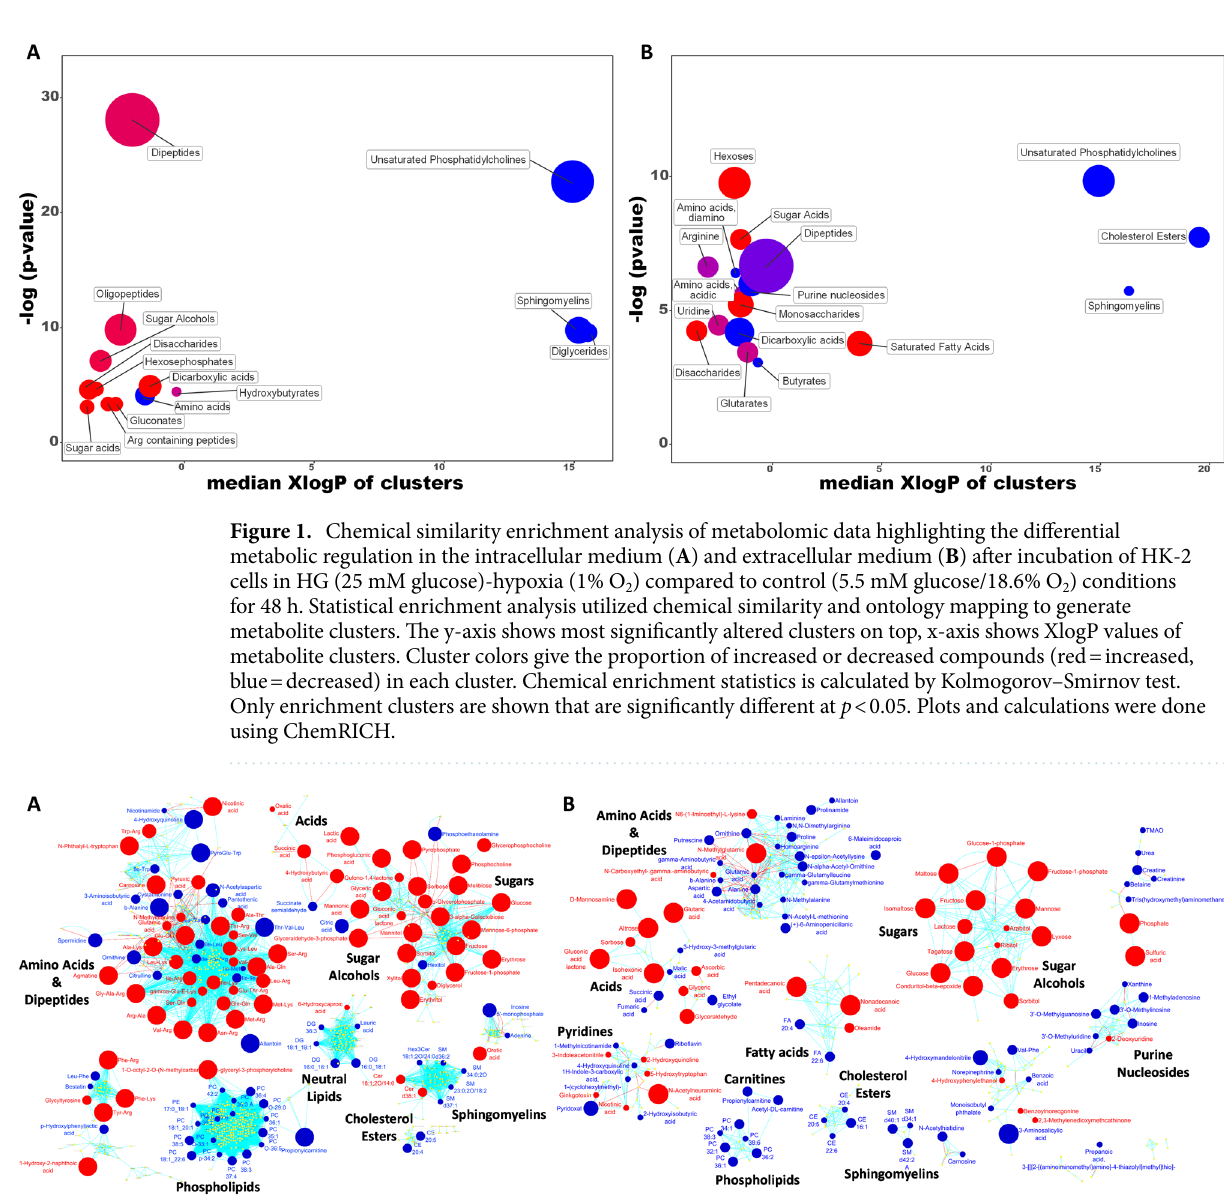
Figure 2. MetaMapp visualization of metabolomic data highlighting the differential metabolic regulation in cell extracts ( A ) and extracellular medium ( B ) after incubation of HK-2 cells in HG (25 mM glucose)-hypoxia (1% O 2 ) compared to control (5.5 mM glucose/18.6% O 2 ) conditions for 48 h. Red edges denote KEGG reactant pair links and light blue edges symbolize Tanimoto chemical similarity at T > 700. Metabolites found significantly increased (FC > 2) are given as red nodes and blue nodes give decreased metabolites (FC < 0.5). Node sizes reflect fold change. Metabolites that were not found to be differentially regulated are given as yellow nodes and left unlabeled for visual clarity. Significance determined using Mann–Whitney U test with FDR < sugar acids were significantly increased. In the extracellular medium, unsaturated PC and SM were decreased as in the cellular extracts, and CE, amino acids (diamino), purine nucleosides, dicarboxylic acids and butyrates were also decreased (Fig. 1B). Arginine, dipeptides, amino acids (acidic), uridine and glutarates were significantly altered with increased and decreased trends, while hexoses, sugar acids, monosaccharides, saturated FA and